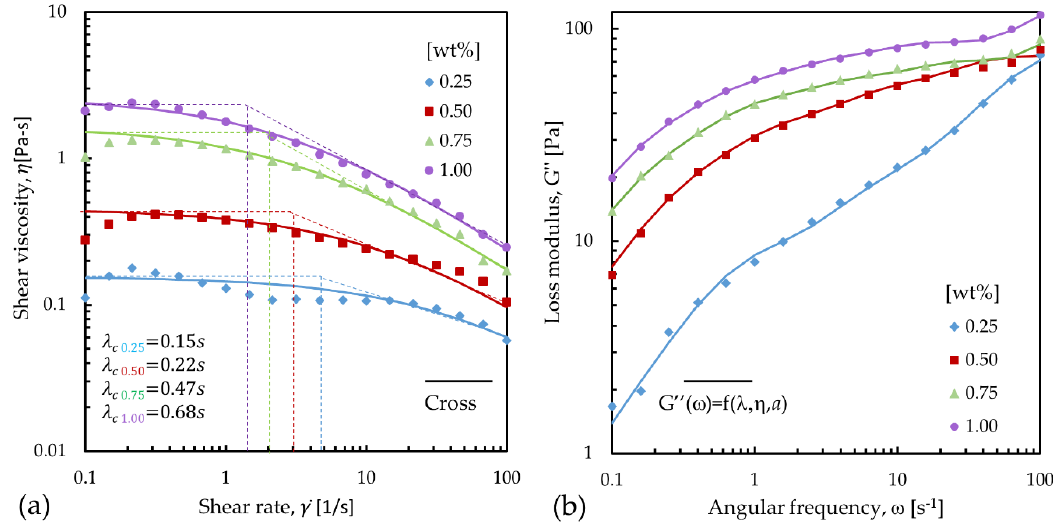
Figure 4. ( a ) Flow curves of SU-8 2002 solutions with concentrations from 0.25 wt% to 1.00 wt% of poly(ethylene) oxide (PEO) and tetrabutylammonium tetrafluoroborate (TBATFB). Graphical determination of the relaxation times using the data fitted from the Cross model. ( b ) Fitting of the G’’ as function of λ, η, and a using Equation (4). Table 4. Critical relaxation times obtained graphically, with the Cross model, and with the relaxation